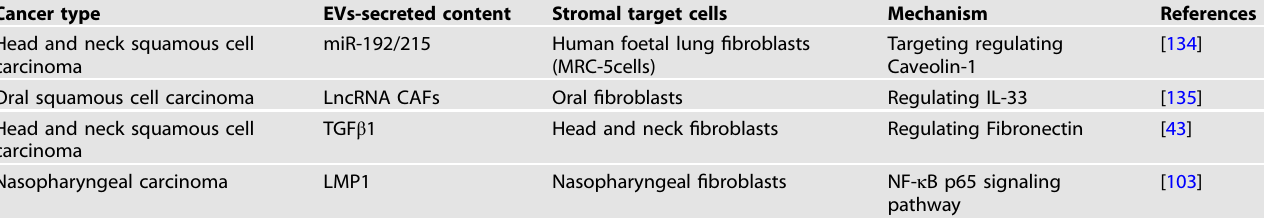
Table 1. Fibroblast activation and reprogramming mediated by HNSCC-derived EVs. Cancer